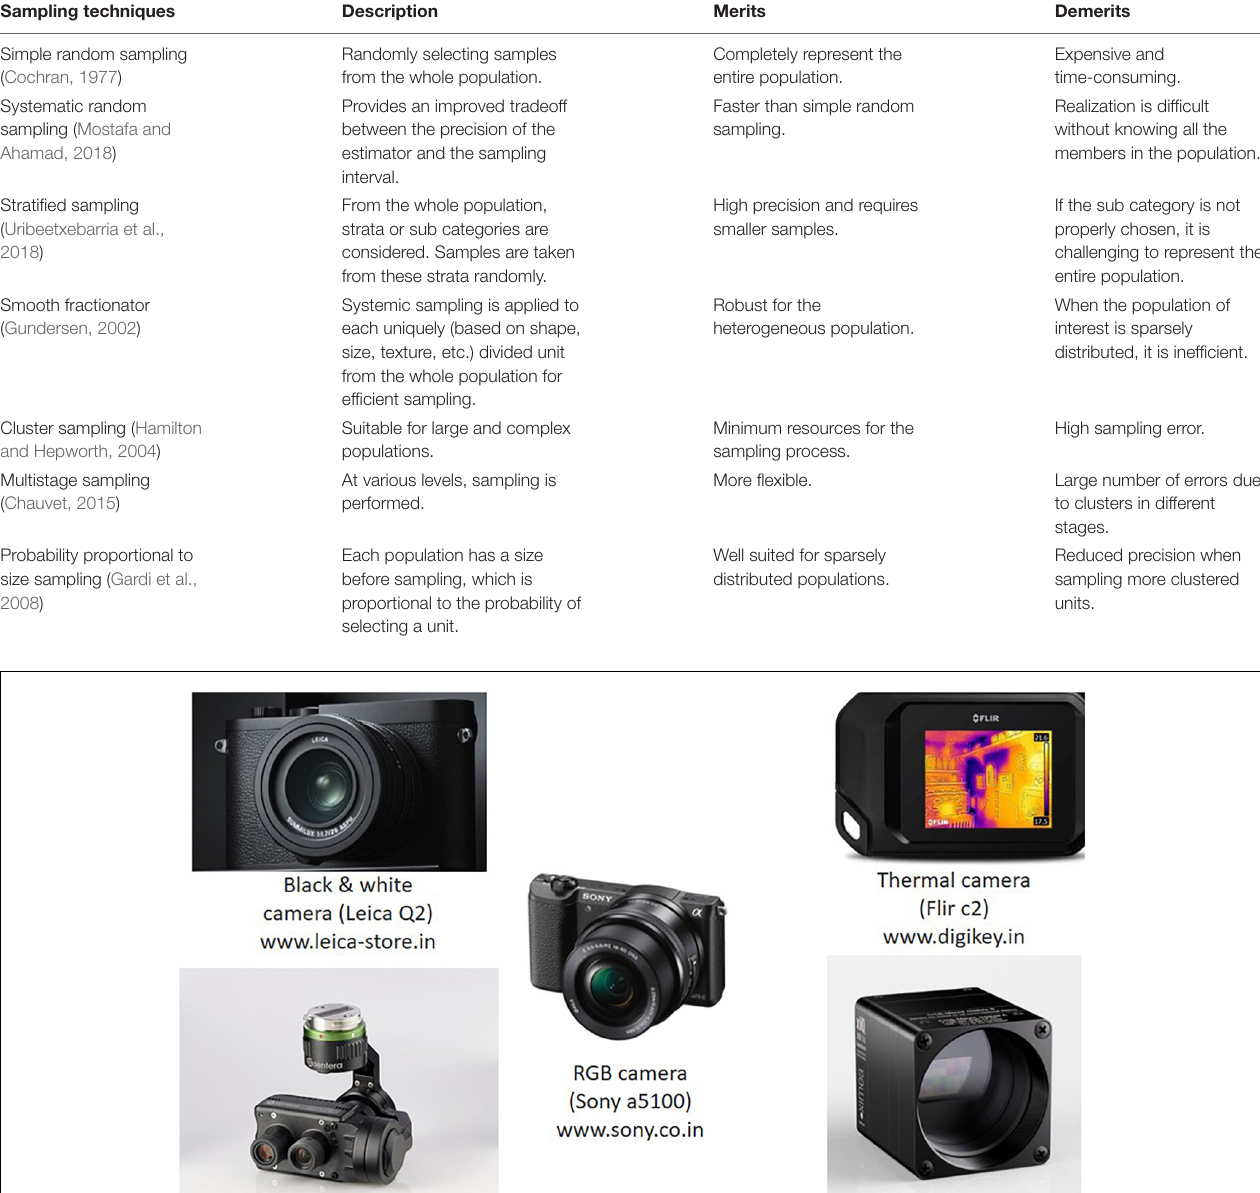
TABLE 1 | Various sampling methods for tree sampling in an orchard.